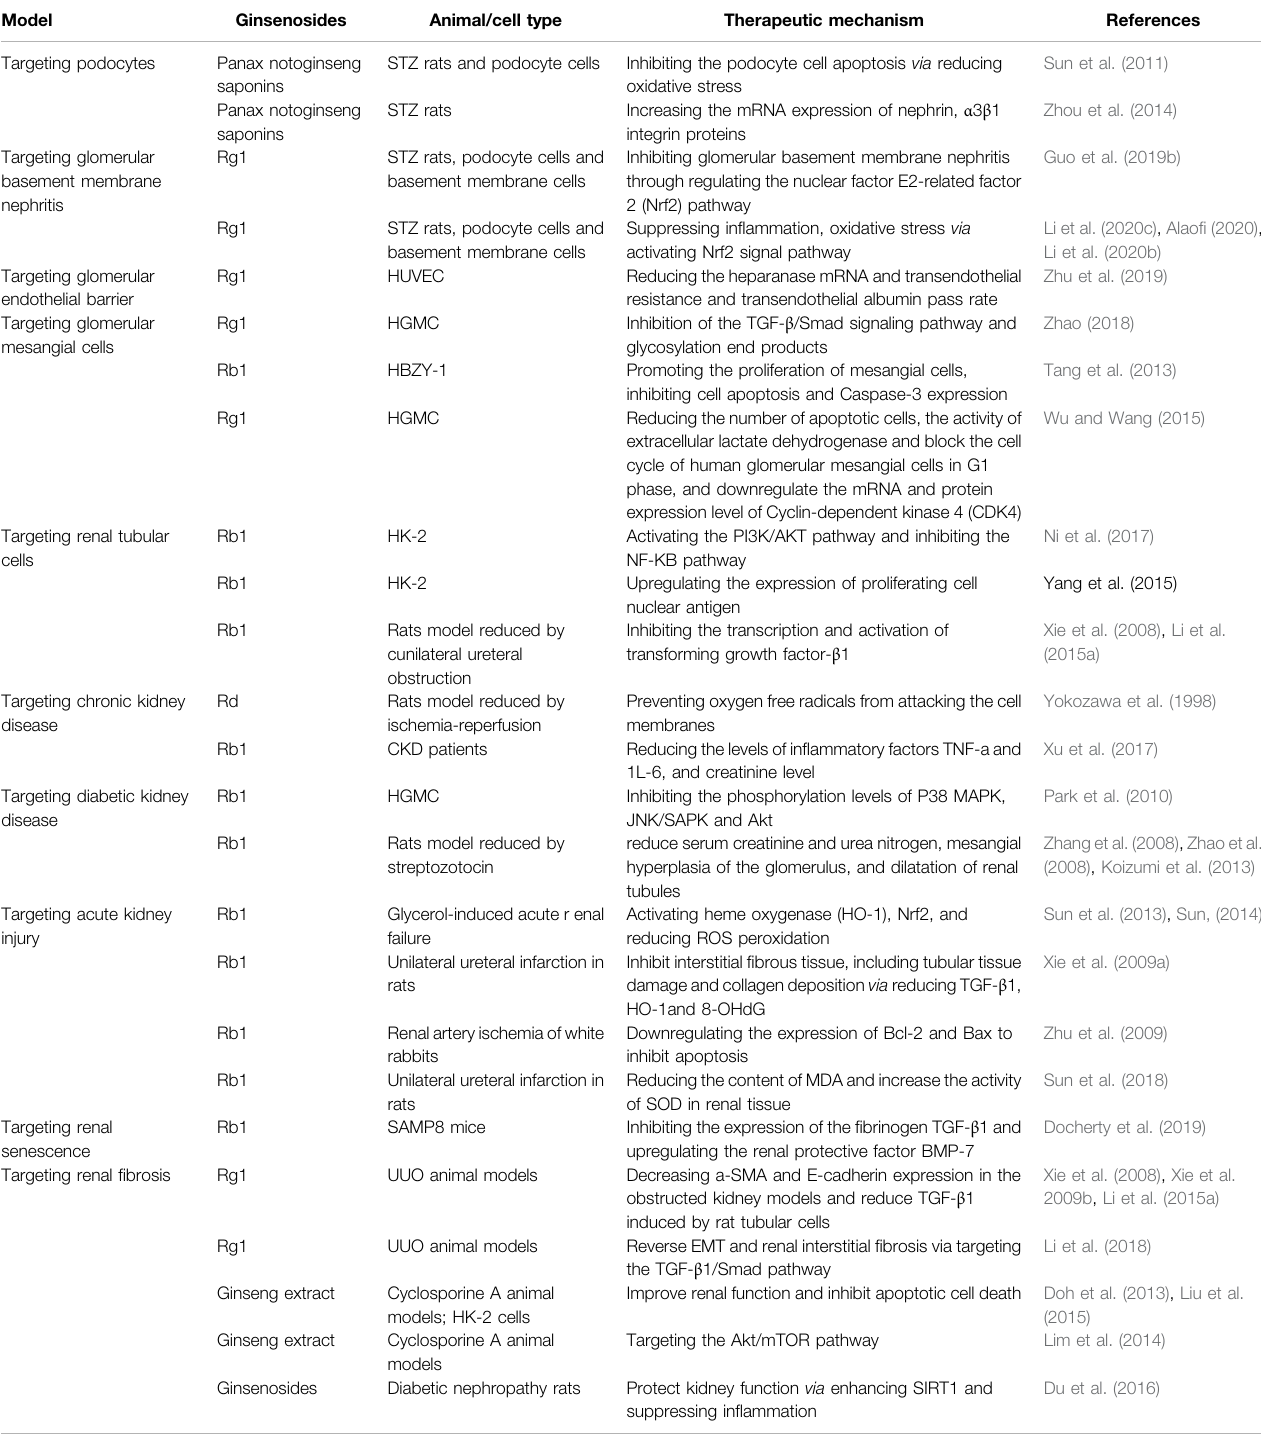
TABLE 1 | Ginsenosides tested in animal or cellular studies for human kidney-related diseases.